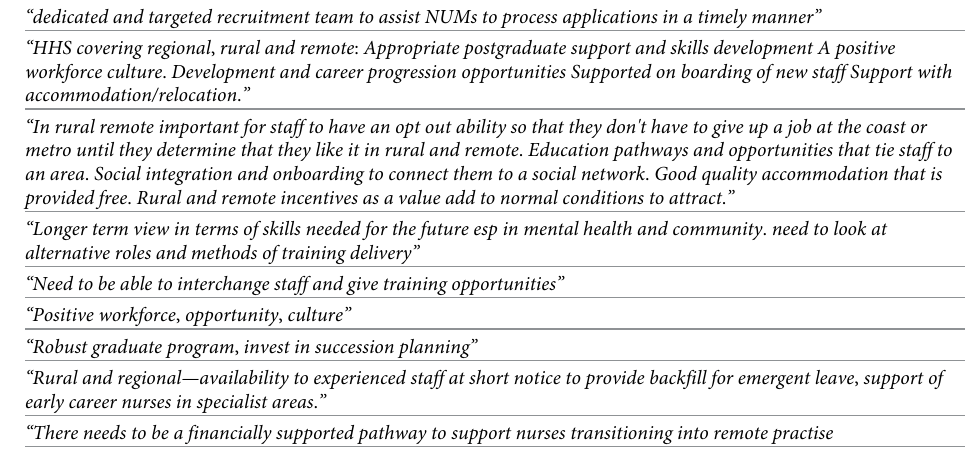
Table 6. Strategies for the successful recruitment of nurses and midwives’ narratives and word cloud.